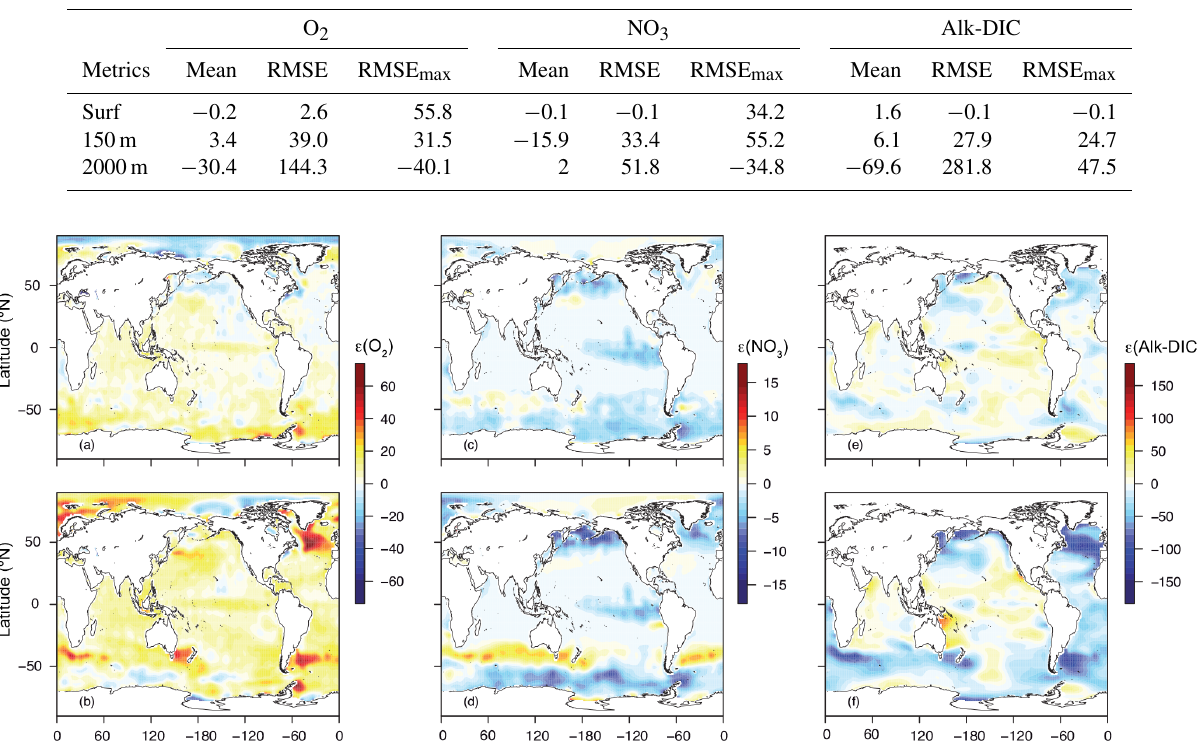
Table 3. Drift in %ky − 1 for oxygen (O 2 ), nitrate (NO 3 ) and total alkalinity minus DIC (Alk-DIC) at surface, 150 and 2000m as simulated by the IPSL-CM5A-LR model. The drift has been computed over the last 250 years of the spin-up simulation using a linear regression fit of the globally averaged concentrations, root-mean squared error (RMSE) and latitudinal maximum root-mean squared error (RMSE max ) with respect to the values at year 250.